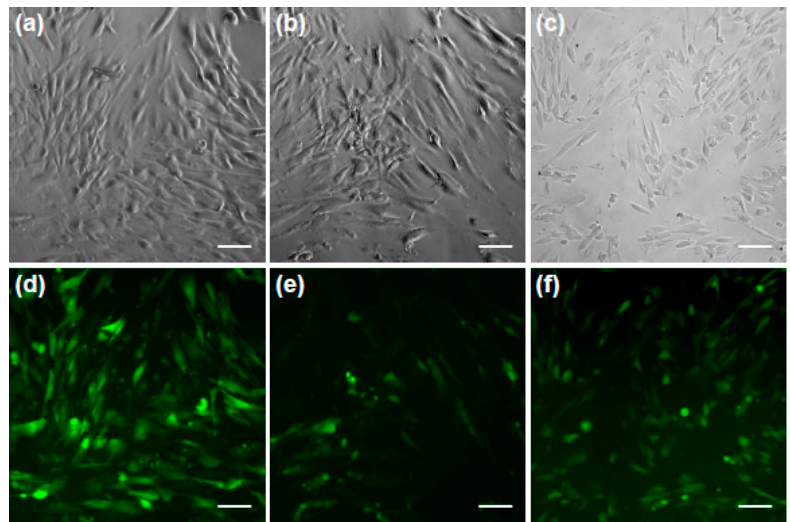
Figure 3. The technique allows spatially-specific irradiation. Only those pHFIB-G that were irradiated with a laser at a RE of 25 mJ/cm 2 were perforated and took up calcein ( b , right side of dashed line); Bright-Field image of the same region ( a ) reveals that cells are evenly distributed and no differences between irradiated and non-irradiated area are visible. Still, only the pHFIB-G in the irradiated area were perforated ( b ); The irradiated cell area is a user defined pattern (e.g., in the shape of a tooth) ( c ). Scale bars: ( a , b ) 200 μ m; ( c ): 2000 μ m.